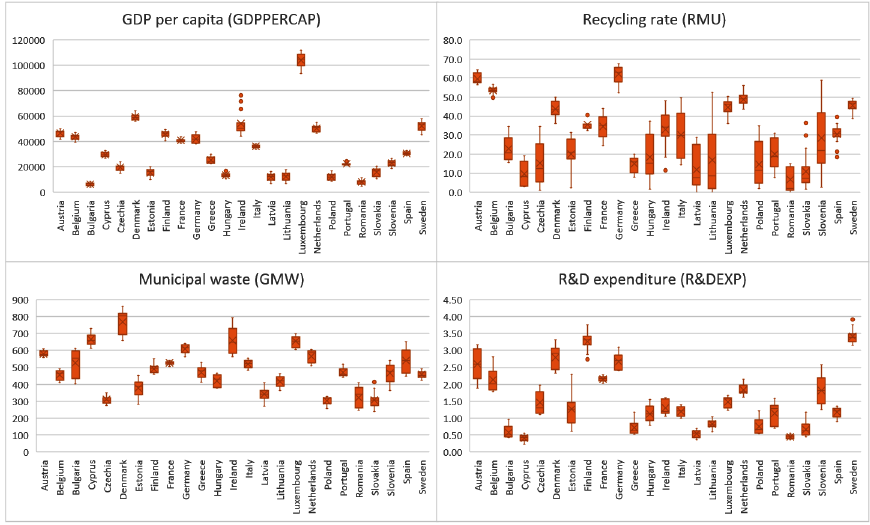
Figure 1. Box plot of the four indicators during